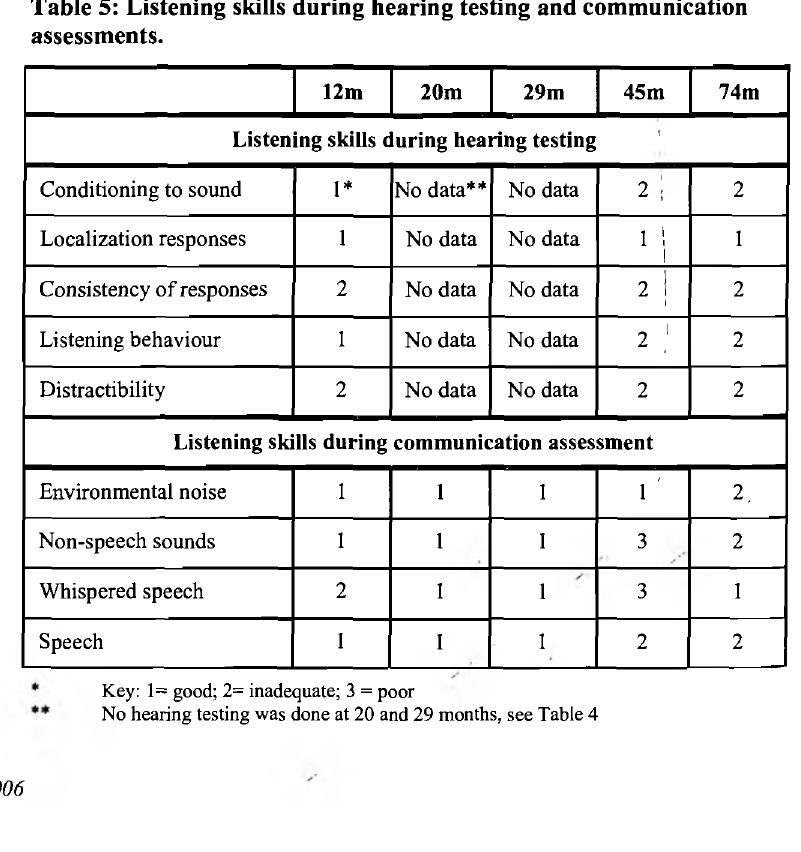
Table 5: Listening skills during hearing testing and communication